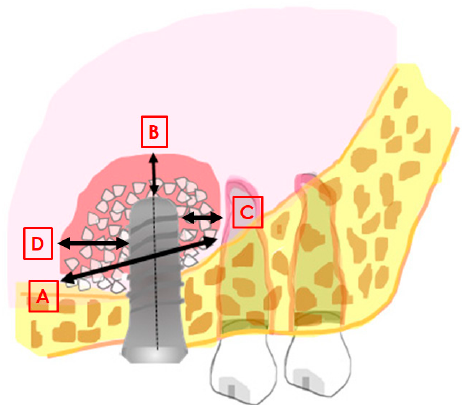
Figure 1. Image explaining the main distances measured in the study. ( A ): mesio-distal extension of the graft; ( B ): distance between the implant apex and the most apical level of the graft; ( C ): linear distance from the mesial aspect of the implant to the most mesial graft extension; ( D ): linear distance from the distal aspect of the implant to the most distal graft extension.